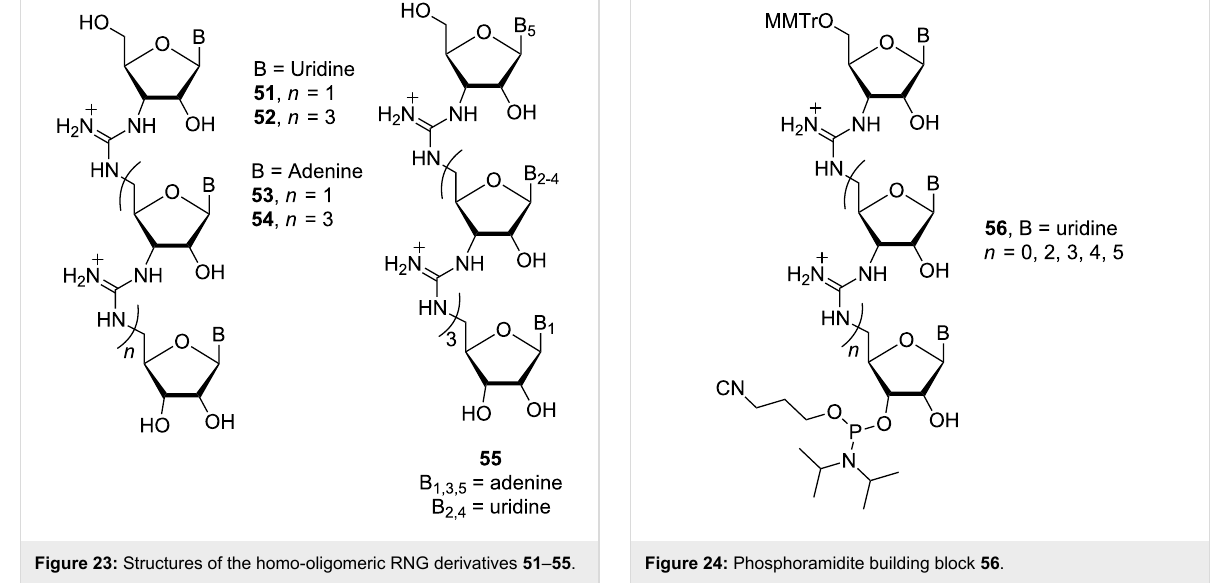
Deoxyribonucleic guanidine homo-oligomeric sequences, consisting of trimeric and octameric thymidyl [100], octameric cytidyl [101] and trimeric 7-deazaguanidyl moieties ( 57 – 60 ) [102] and a mixed-base tetramer [103] and hexamer [104] ( 61 – 63 ) were synthesised using the same strategy as noted above for RNG synthesis (Figure 25).